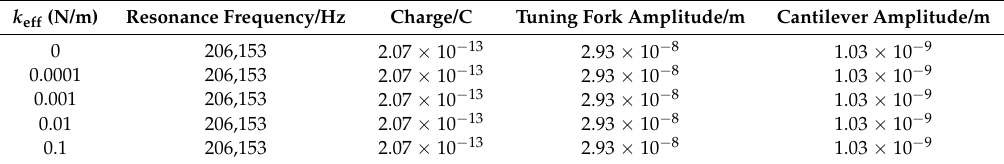
Table 5. The second eigenmode results: ANSYS simulation with different values of k eff . k eff /(N/m) Resonance Frequency/Hz